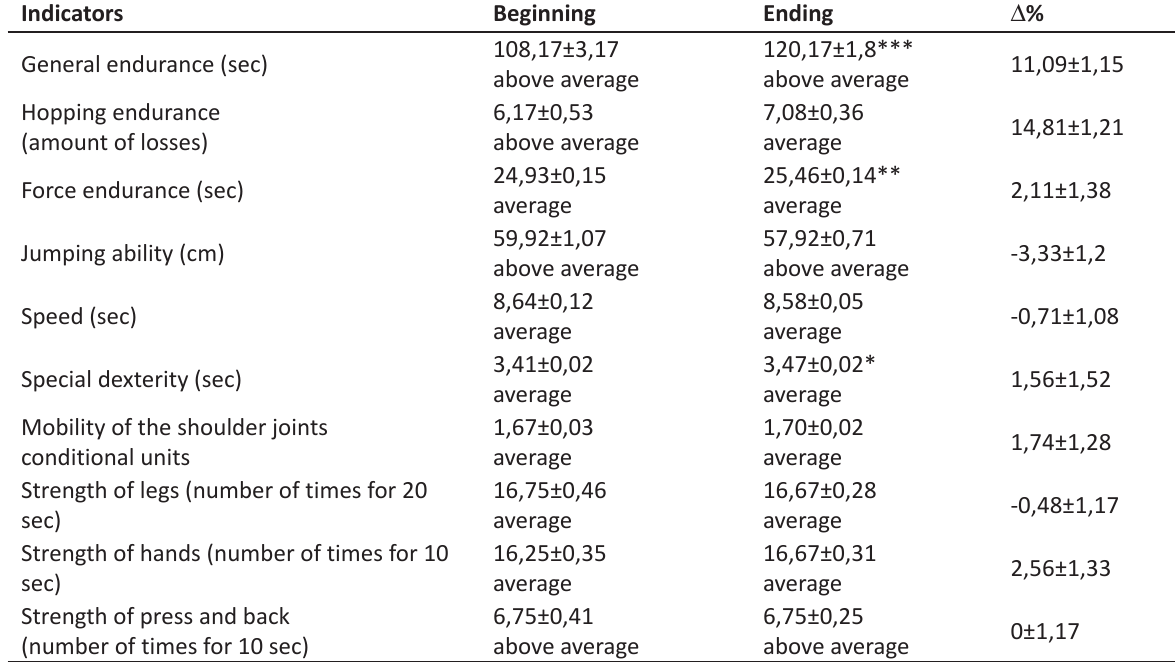
Table 4. Indicators of special physical fitness of volleyball players at the beginning and end of the second stage of the experiment ( х